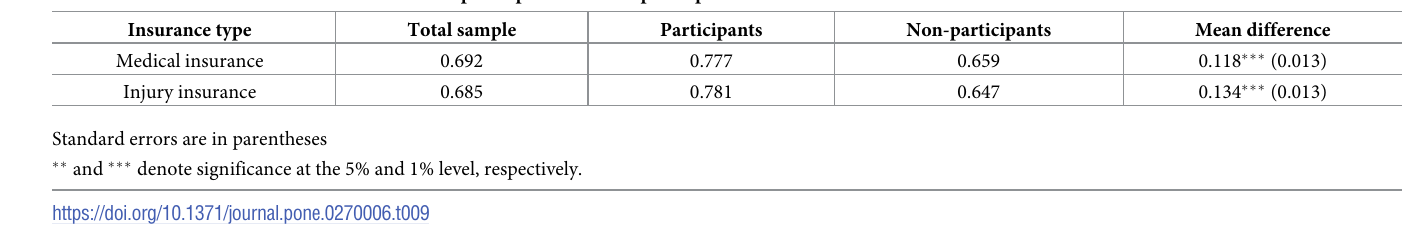
Table 9. Differences in health insurance between participants and